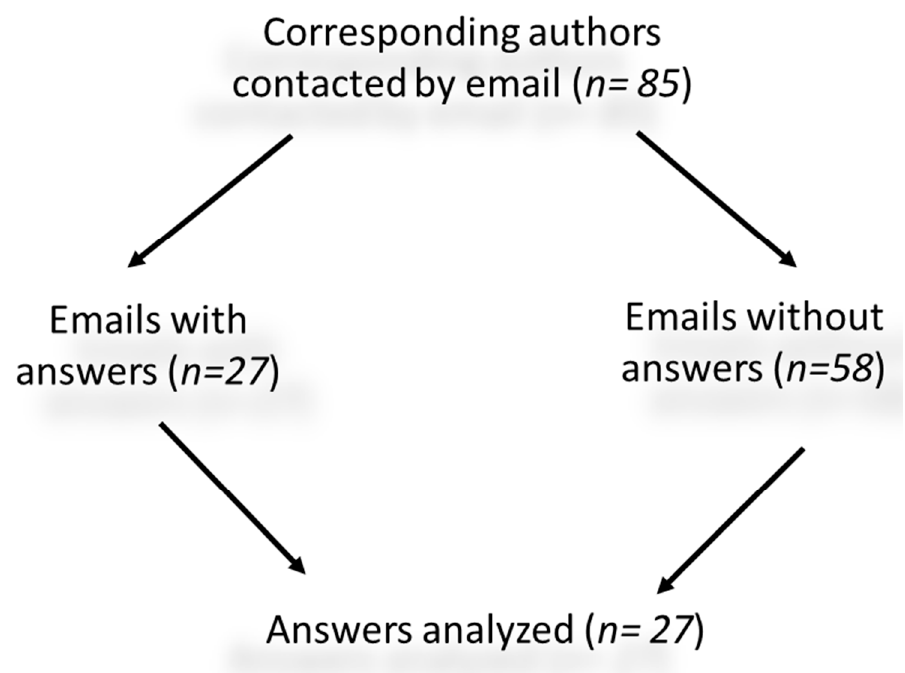
Figure 4. Questionnaires analyzed.